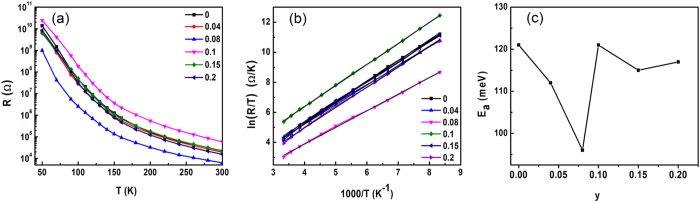
(a) Temperature dependence of the resistances in the Sm0.5Sr0.5Mn1−yCryO3 thin films. (b) The relation between ln(R/T) and 1000/T for Sm0.5Sr0.5Mn1−yCryO3 films. The straight lines represent the best fits to the Emin–Holstein model of SPH. (c) Activation energy dependence of doping concentration for all films.